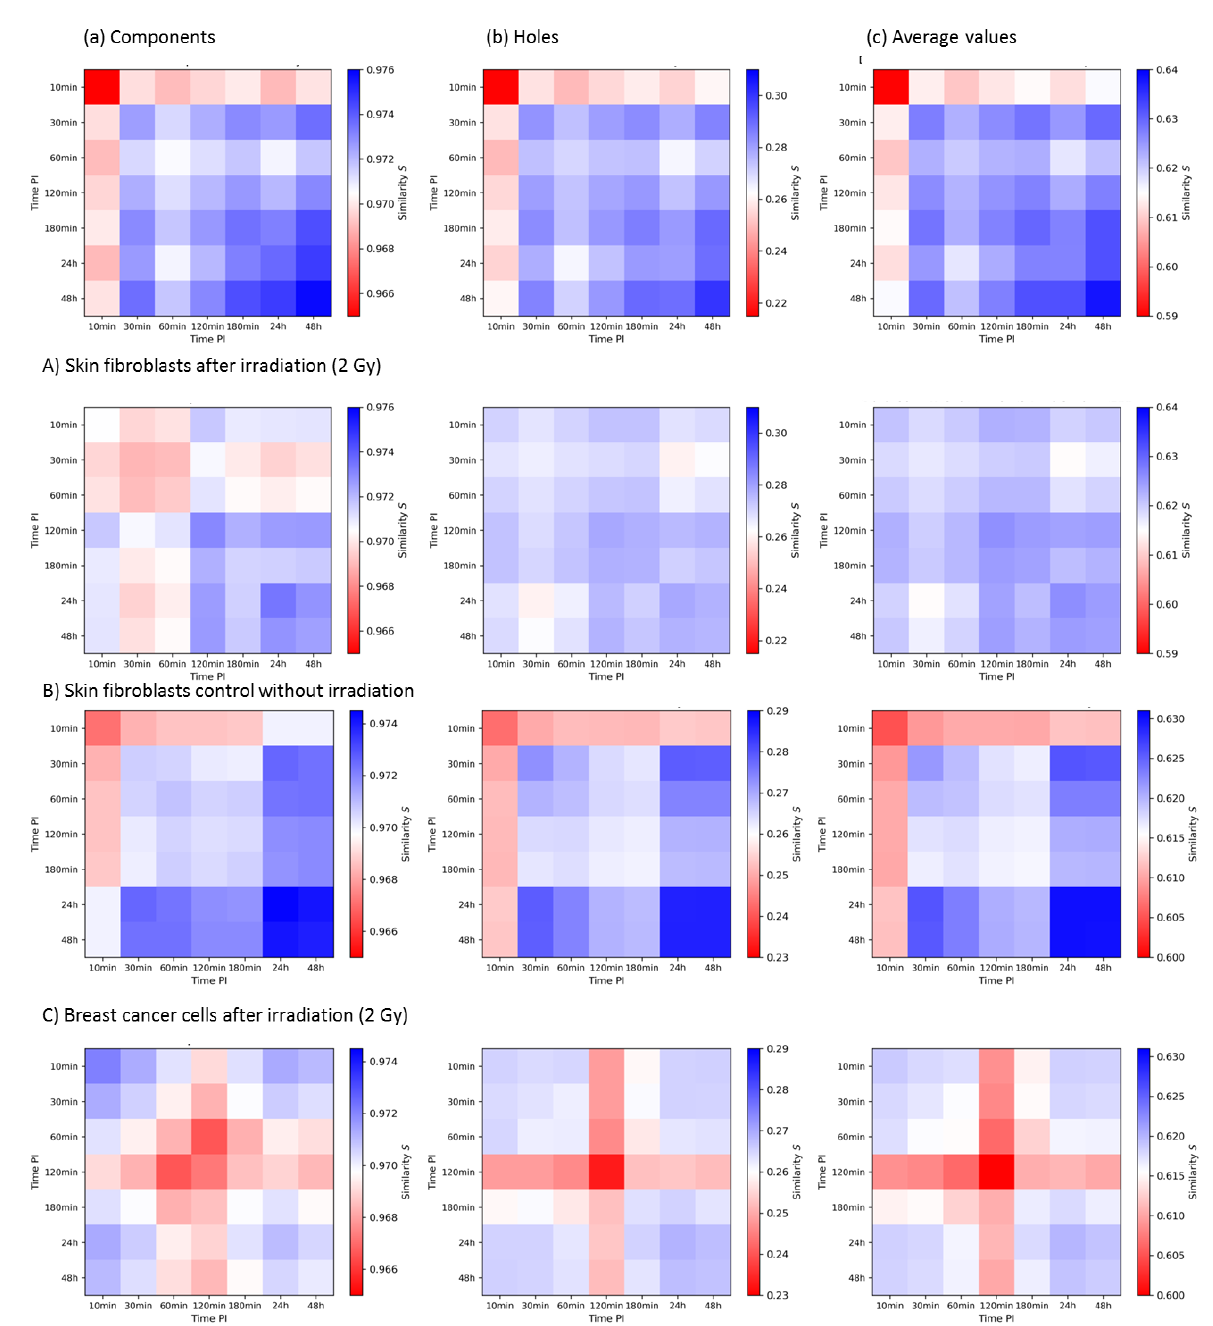
Figure 8. Second-generation heatmaps of MRE11 clusters of components ( a ) and holes ( b ) and average values of both ( c ) for the skin fibroblast cell line CCD-1059SK ( A , B ) and the breast cancer cell line MCF-7 ( C , D ). Each value of a pixel of these heatmaps represents the mean value of one 1st-generation heatmap. Note the differences in the color bars between ( a – c ), while the visual pattern may be similar.